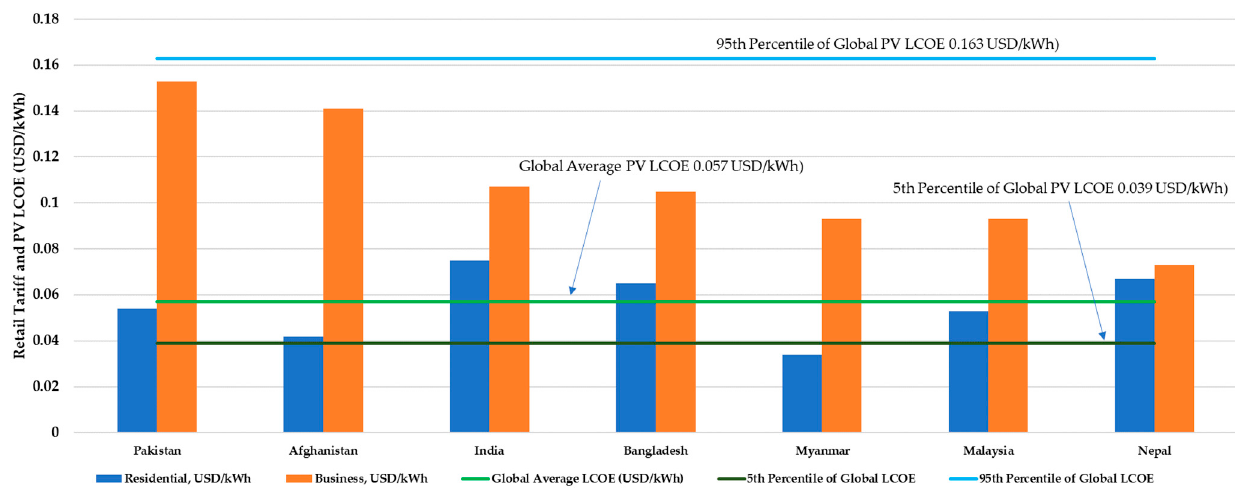
Figure 12. Average retail electricity tariff for residential and business consumers in South Asian countries and global average LCOE for utility‑scale solar PV